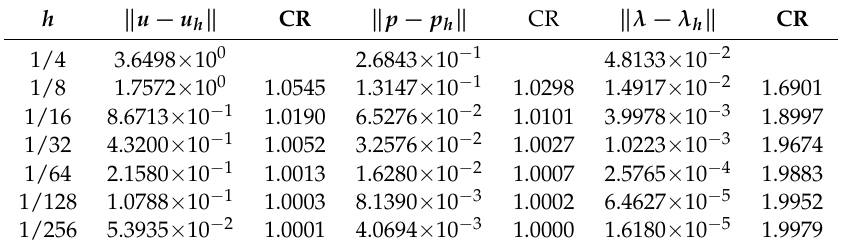
Table 8. Discrete errors and convergence rates for Example 2 at time T = 1 with δ t = 0.1 and nb =